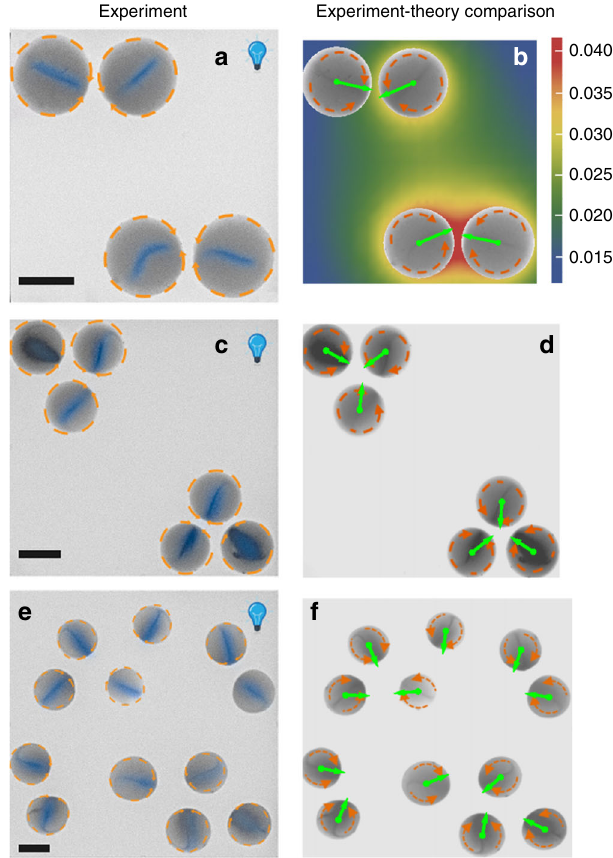
Fig. 4 Experimental observations and theoretical prediction of the fl ow directors. The emergent alignment of the directors of the drops, forming various con fi gurations with low symmetry, caused by the superposition of long-ranged pair communication (see Supplementary Note 3). Left column: experiment (for visual clarity, the region around the director is shaded in blue in accordance with the observed gray scale density); right column: comparison with the theoretical prediction (green arrows, see Supplementary Note 3) with the activity strength Q i taken to be proportional to the area of the base of the i -th drop. The scale bars in the left panels correspond to 150 μ m. The color background in the top right panel depicts the chemical fi eld (here O 2 ), in units of Q / R , that determines the orientation of the director of the top left drop, i.e., the number density of the chemical due to the other three drops in